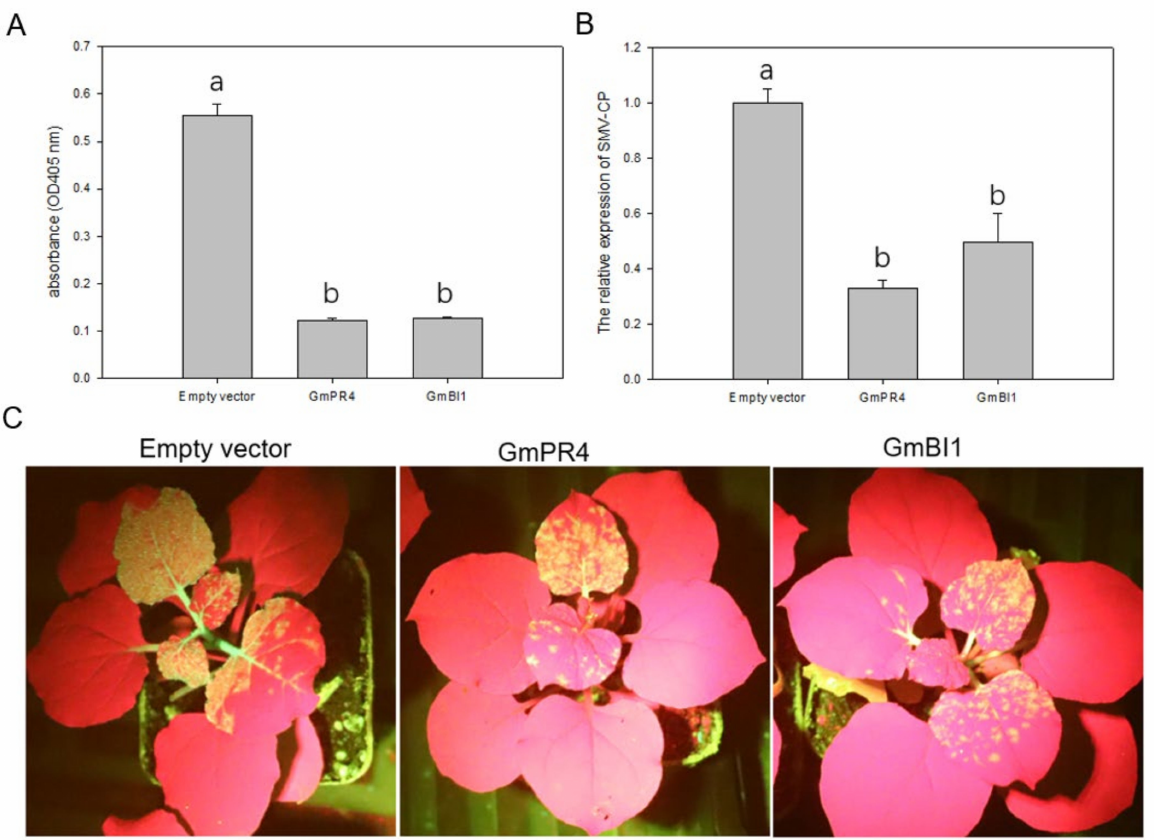
Figure 7. Transient overexpression of GmPR4 and GmBI1 in N. benthamiana. The accumulation of SMV in infiltrated leaves was detected by ELISA ( A ) and qRT-PCR ( B ) at 7 days post infiltration. Each experiment was repeated three times with error bars indicating standard deviation (SD). The significant differences were tested by one-way ANOVA, p < 0.05. Bars with identical letters are not significantly different. ( C ) The GFP signals in upper leaves were observed under ultraviolet light at 12 days post